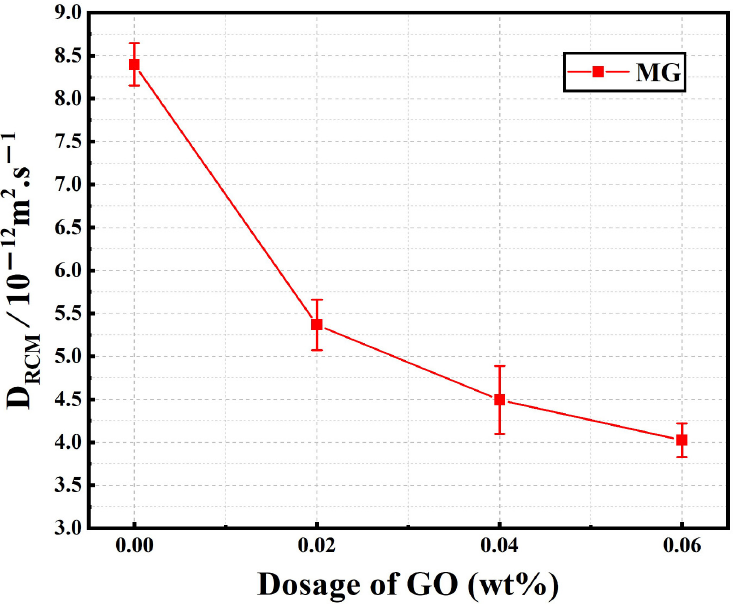
Figure 12. Chloride migration coefficient of normal cement mortar samples (M, MG2, MG4, and MG6).